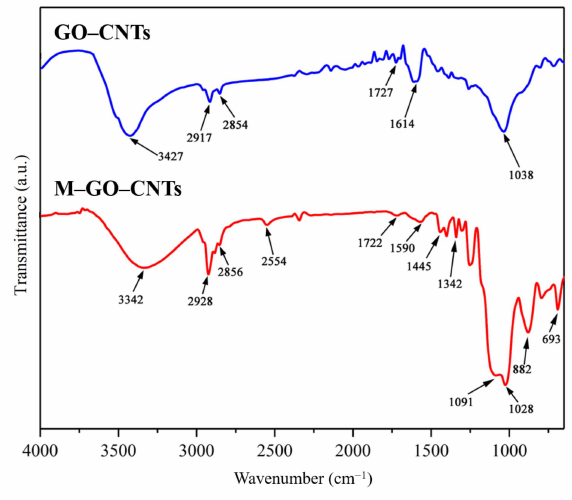
Figure 4. FTIR spectra of GO-CNTs and